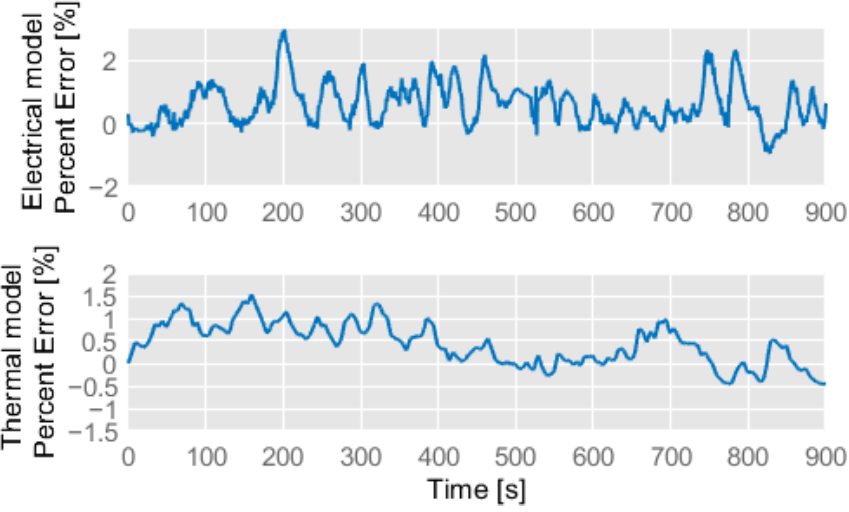
Figure 11. Electrical and thermal model errors.